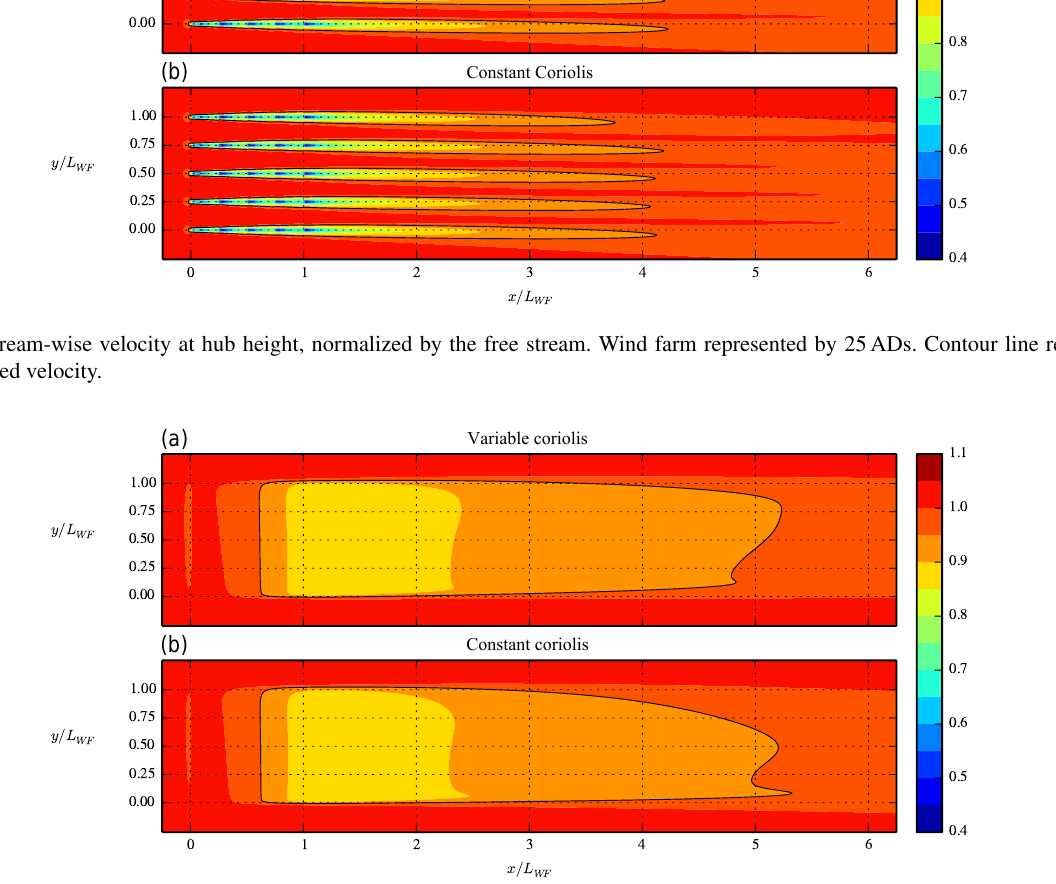
Figure 9. Stream-wise velocity at hub height, normalized by the free stream. Wind farm represented by a high roughness. Contour line represents 95% recovered